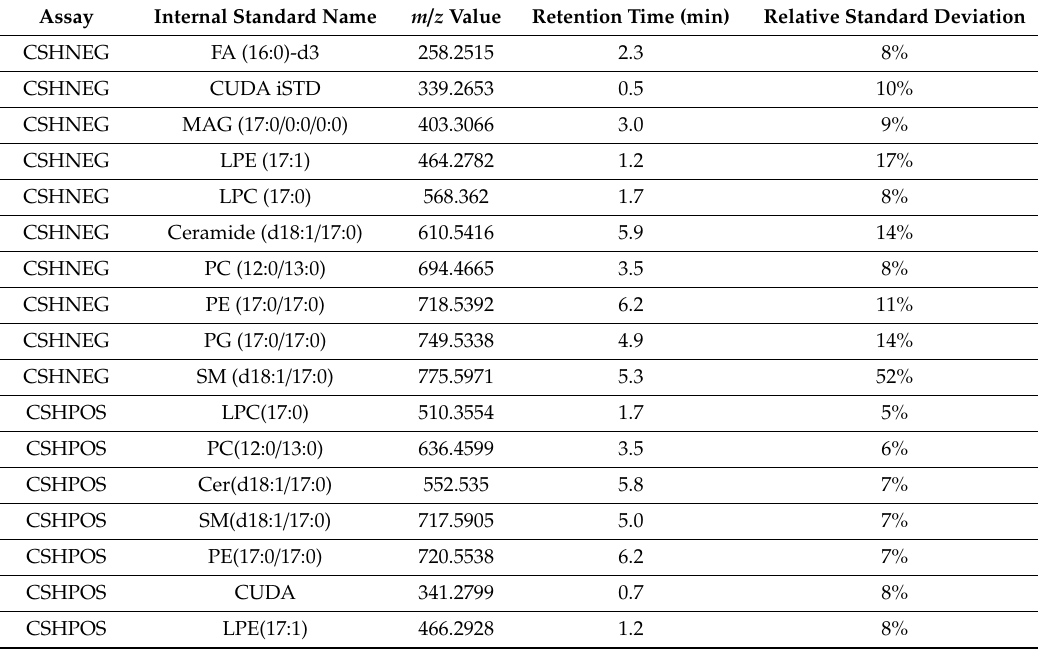
Table 3. Relative standard deviation of labelled internal standards for the liquid chromatography / mass spectrometry (LC / MS)